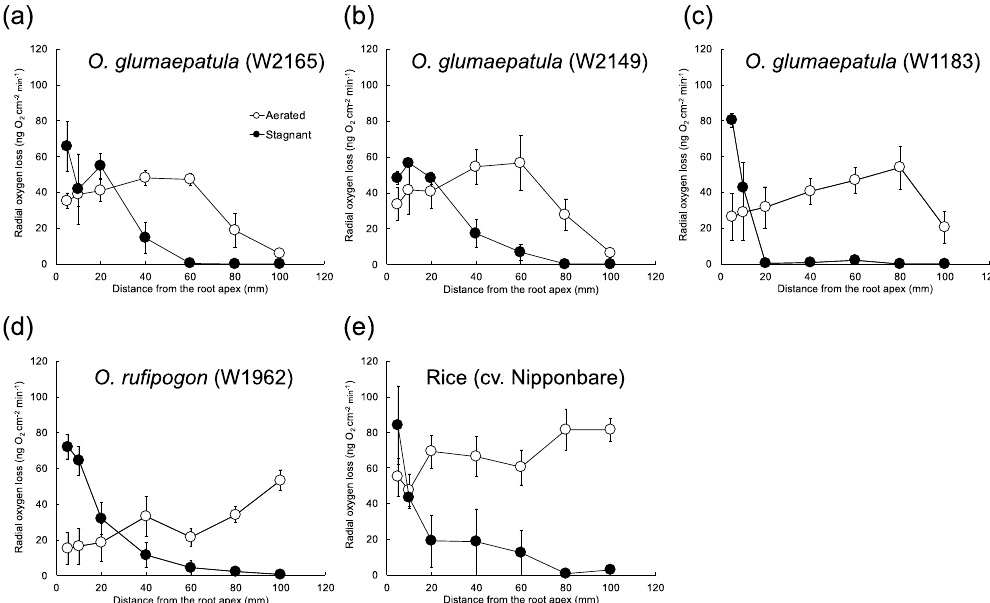
Figure 1. Rates of radial oxygen loss (ROL) along adventitious roots in accessions of O. glumaepatula , O. rufipogon , and rice (cv. Nipponbare) under aerated or stagnant conditions. W2165 ( a ), W2149 ( b ), and W1183 ( c ) of O. glumaepatula came from wetlands. W1962 ( d ) of O. rufipogon came from habitats other than wetlands. For a control that forms an inducible ROL barrier, cv. Nipponbare ( e ) was used. ROL along adventitious roots (115–120 mm length) was measured by Pt cylindrical electrode. Plants were grown in aerated nutrient solution for eight days and then transferred to deoxygenated stagnant 0.1% agar solution or continued aerated solution for 13–15 days. Mean ± standard error (SE). n = 3 or 4.